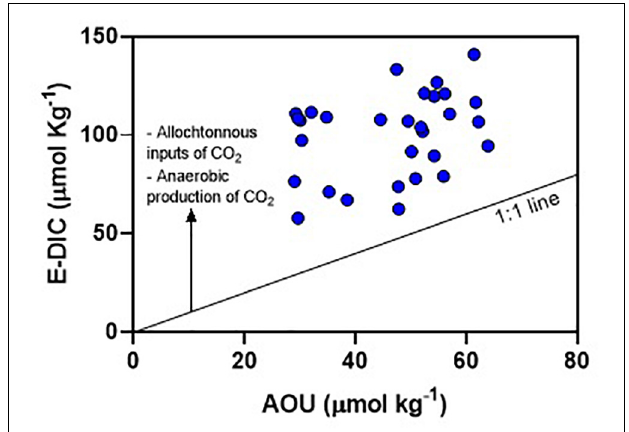
FIGURE 8 | Relationship between the excess dissolved inorganic carbon (E-DIC) and apparent oxygen utilization (AOU) for Oct-2017. The 1:1 line represents the quotient between CO 2 and O 2 during the processes of photosynthesis and